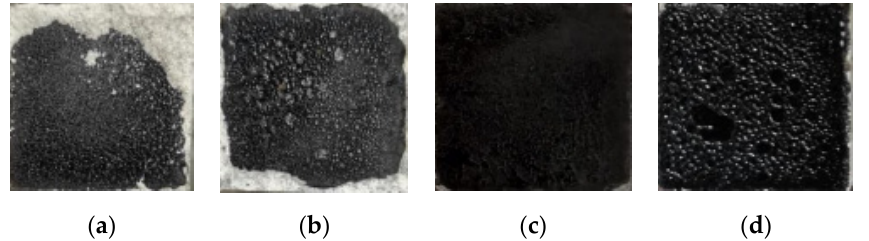
Figure 12. Changes in fracture surface with increased curing age (using 70# petroleum asphalt). ( a ) 3d, ( b ) 7d, ( c ) 14d, ( d ) 21d, ( e ) 28d.